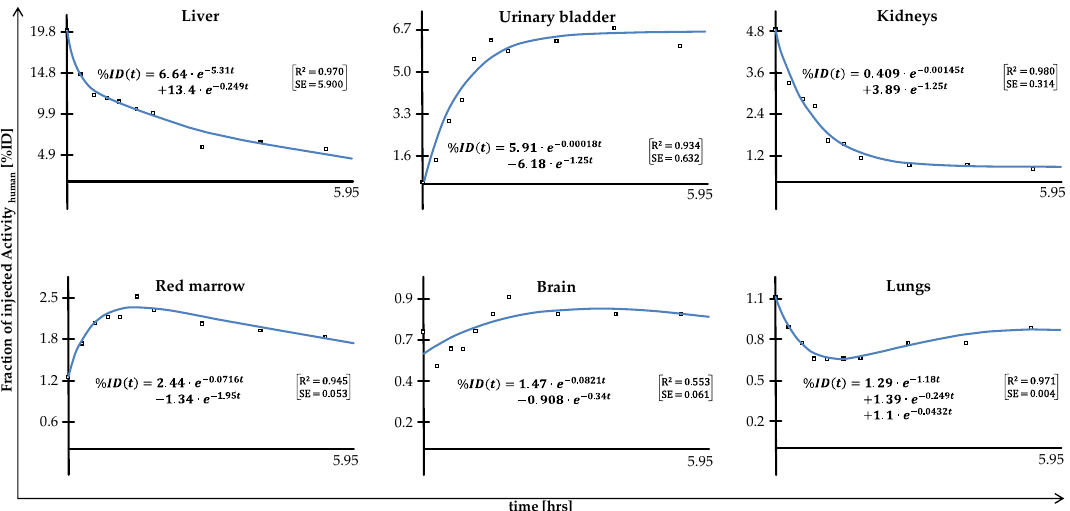
Figure 1. Examples of the mono-, bi-, or tri-exponential fits, including exponential fit equations and parameters of fit goodness (R-squared and squared error) of the human scale time–activity data using the EXM-Module of OLINDA. All fits are presented in the supplemental material (Figures S1– S3).